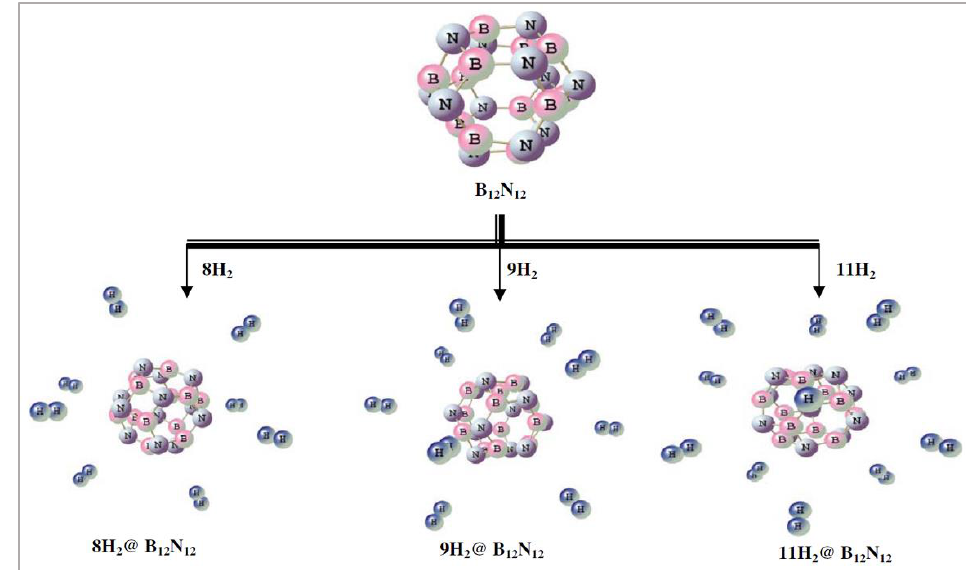
Figure 6. Energy minima forms (B3LYP/6-311+G(d)) of B 12 N 12 and selected hydrogen molecule- bound analogues. This figure is reproduced from Reference [20].